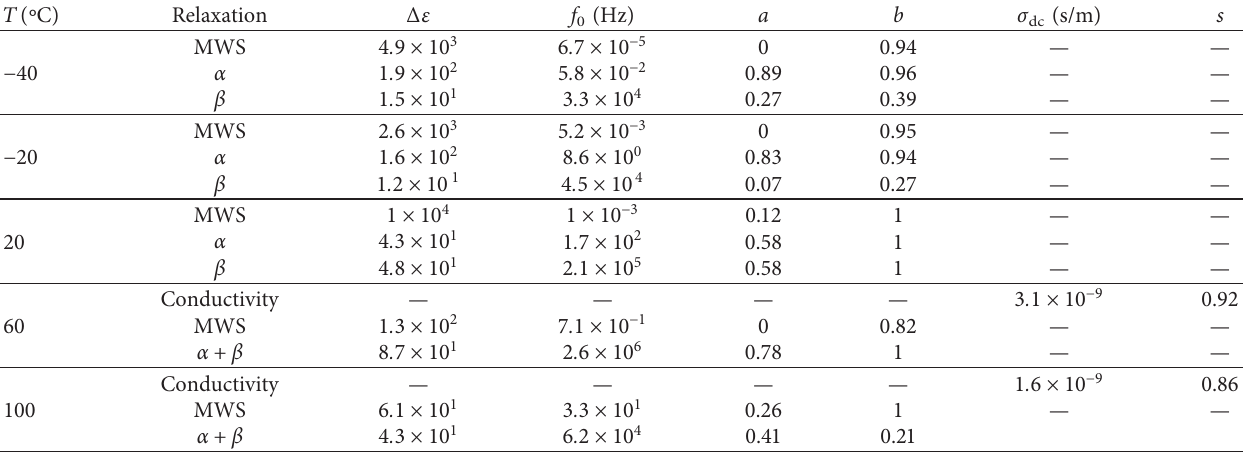
Table 6: Fitting parameters of the specific relaxation process.